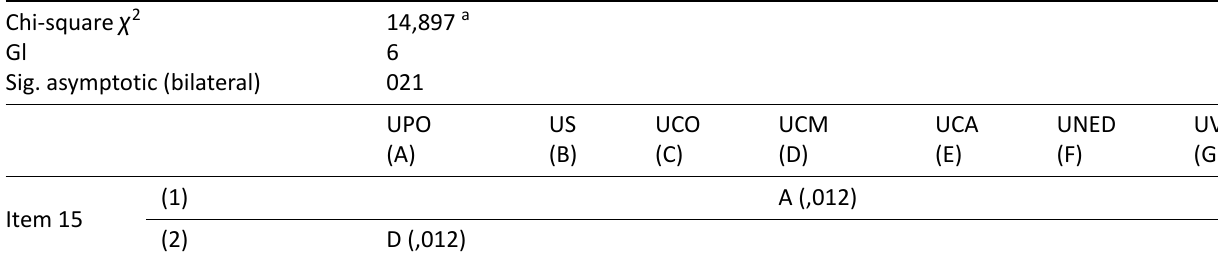
Table 6. Chi‐square and comparisons of proportions (item 15).